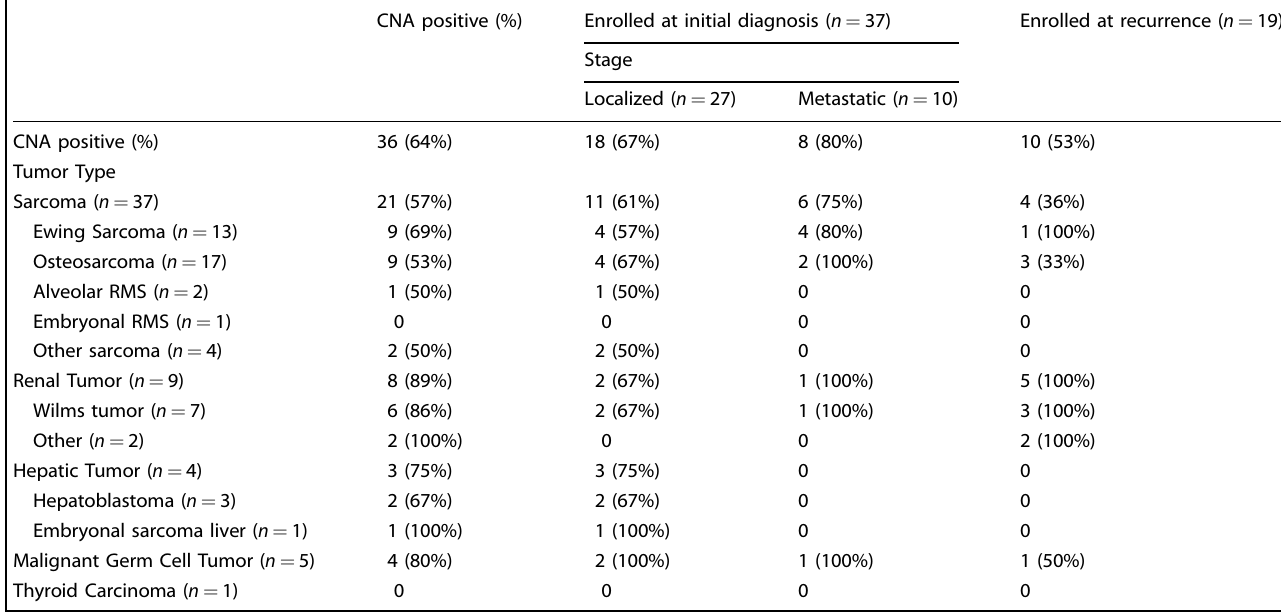
Table 2. Detection of copy number alterations (CNA) in the plasma by histologic subtype.